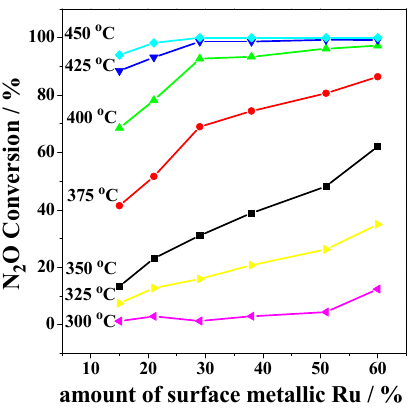
Figure 6. Relationship between N 2 O conversion and the amount of surface metallic Ru.